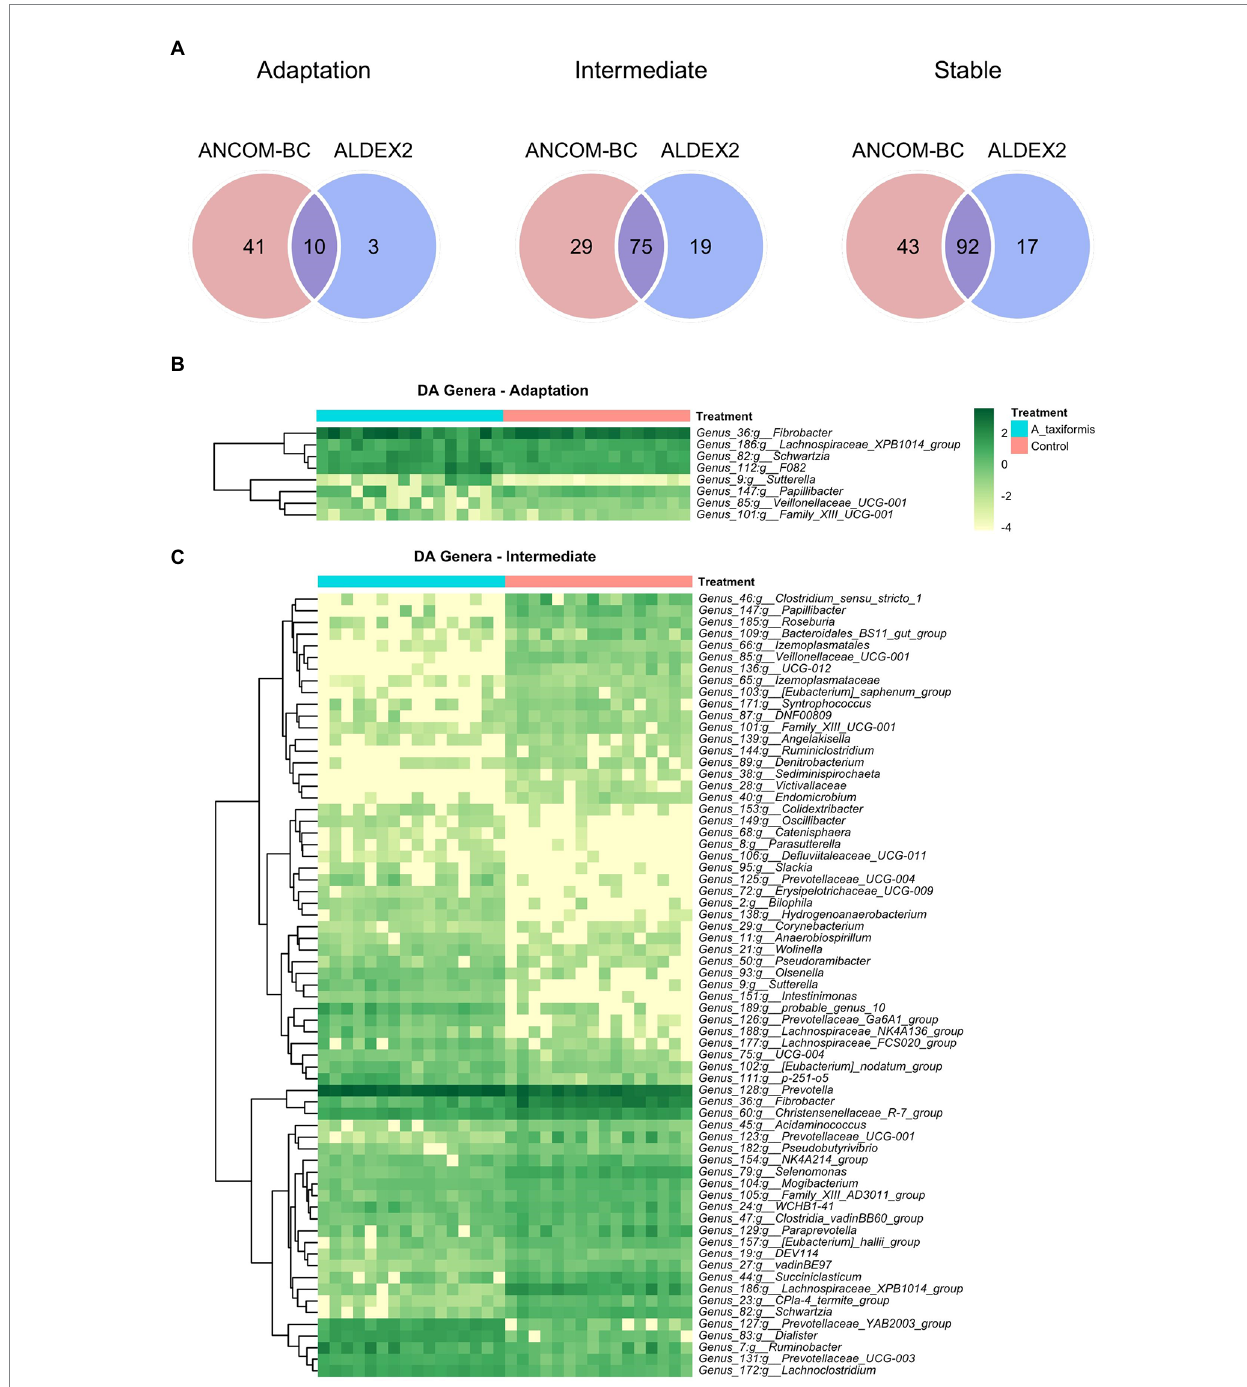
FIGURE 6 Differential abundance (DA) analysis of bacterial genera. (A) Venn diagrams showing the overlap between ANCOM-BC and Aldex2 results. Heatmaps of DA genera for the (B) adaptation and (C) intermediate phases are shown. Raw count data was log transformed for plotting. Genera denoted as uncultured or unknown are excluded from the